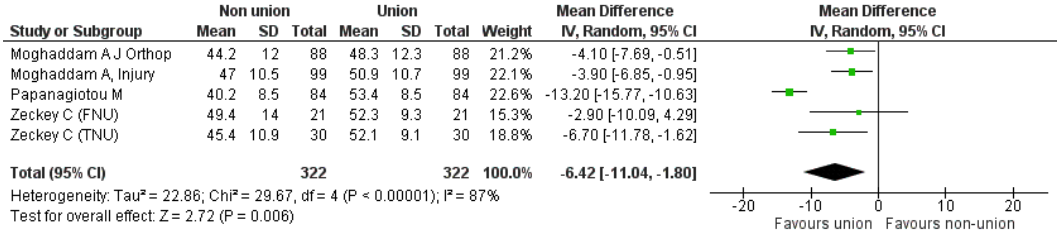
Figure 5. SF-12 PCS pooled analysis between nonunion and union.